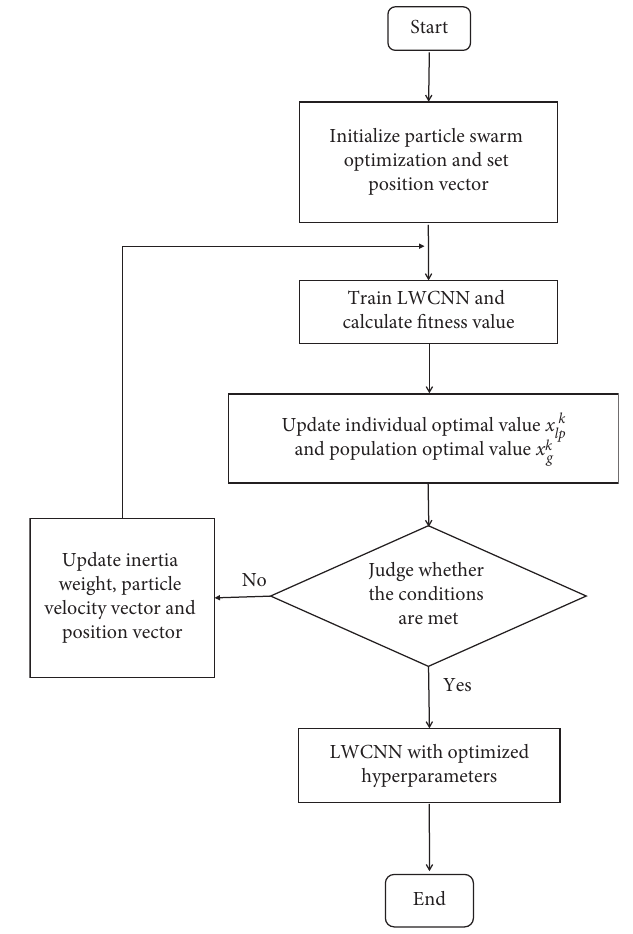
Figure 3: The flowchart of PLCNN